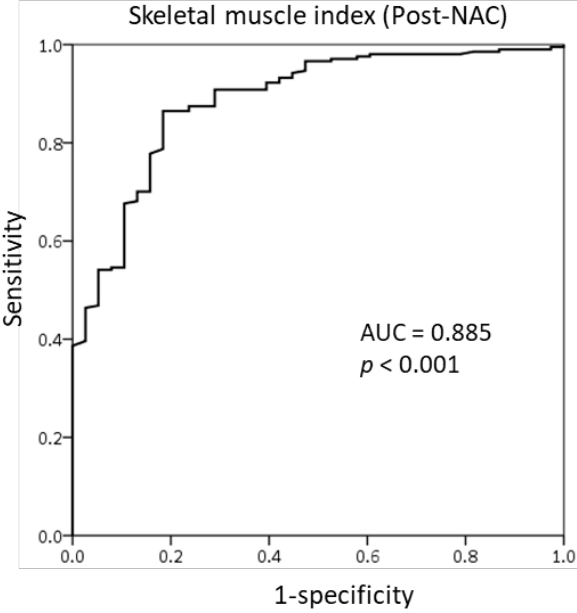
Figure 3. Receiver operating characteristic curve of the skeletal muscle index at the T4 level after the completion of neoadjuvant chemotherapy.